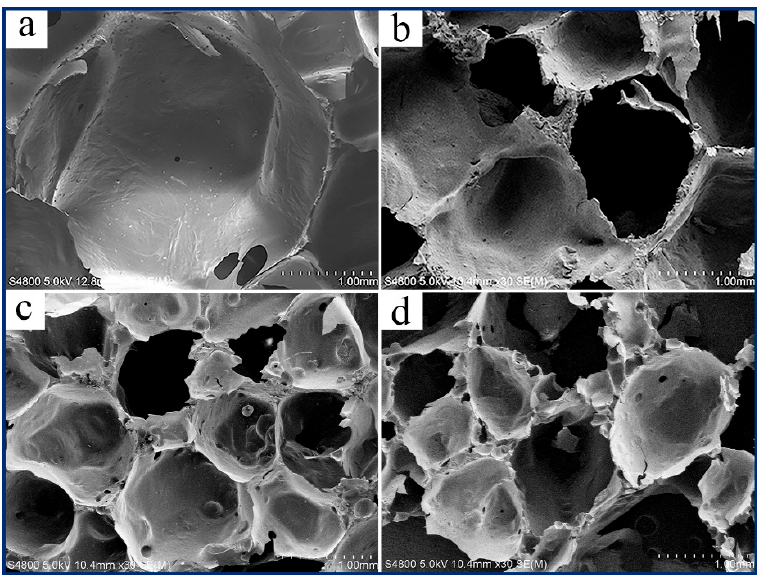
Figure 6. The SEM images of ( a ) RPUF, ( b ) RPUF/SiO 2 (7 wt %), ( c ) RPUF/PS (10 wt %), and ( d ) RPUF/PB (10 wt %).